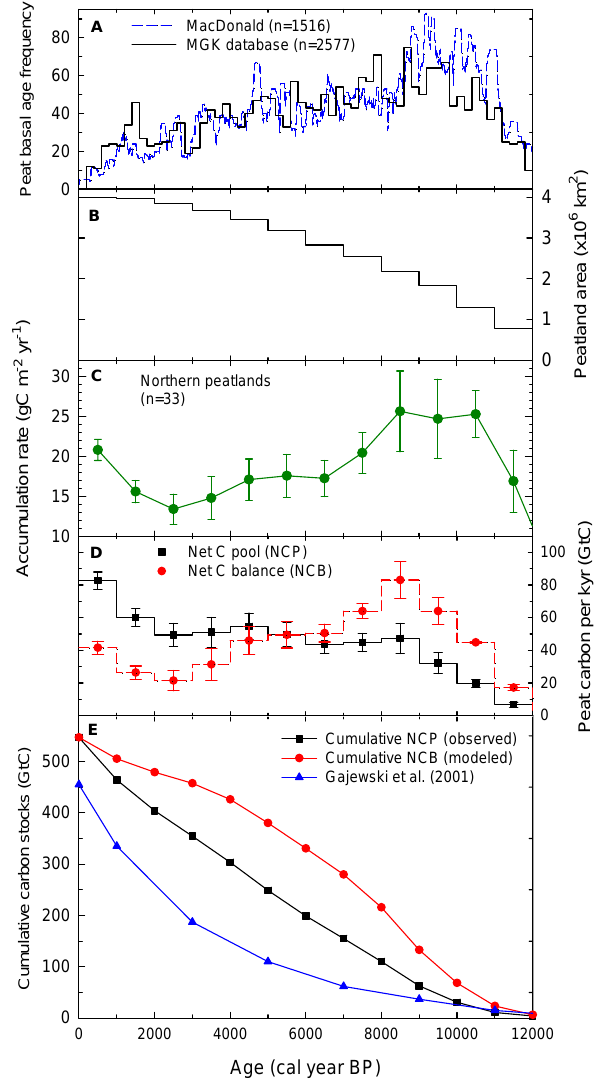
Fig. 1. Peatland change over time during the Holocene. (A) Basal ages and peatland initiation histories (dashed line ( n = 1516): Mac- Donald et al. 2006; solid line (2577): combined datasets from Mac- Donald et al., 2006; Gorham et al., 2007; and Korhola et al., 2010 as in Yu et al., 2012b); (B) peatland area change at 1000-yr inter- vals over time estimated from cumulative basal age histogram as in (A) (MacDonald et al., 2006) and the present peatland area of 4 × 10 6 km 2 (Yu, 2011); (C) carbon accumulation rates based on 33 sites across northern peatlands with error bars from standard er- rors of the means (Yu et al., 2009); (D) observed net carbon pool (NCP) and modeled net carbon balance (NCB) for northern peat- lands at 1000-yr intervals, with standard errors as error bars (Yu et al., 2010; Yu, 2011); (E) cumulative peatland carbon stocks from NCP (squares; Yu et al., 2010), NCB (circles), and from scaling the carbon stocks of Gorham (1991) using Sphagnum -spore data (Gajewski et al.,